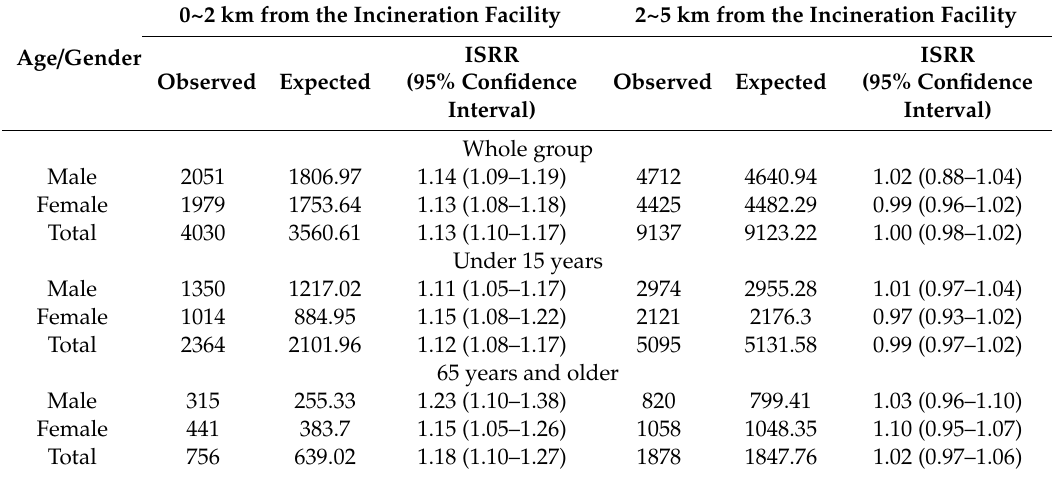
Table 3. ISRR of Asthma-related Admissions by the Distance from the Facility and Age Group,